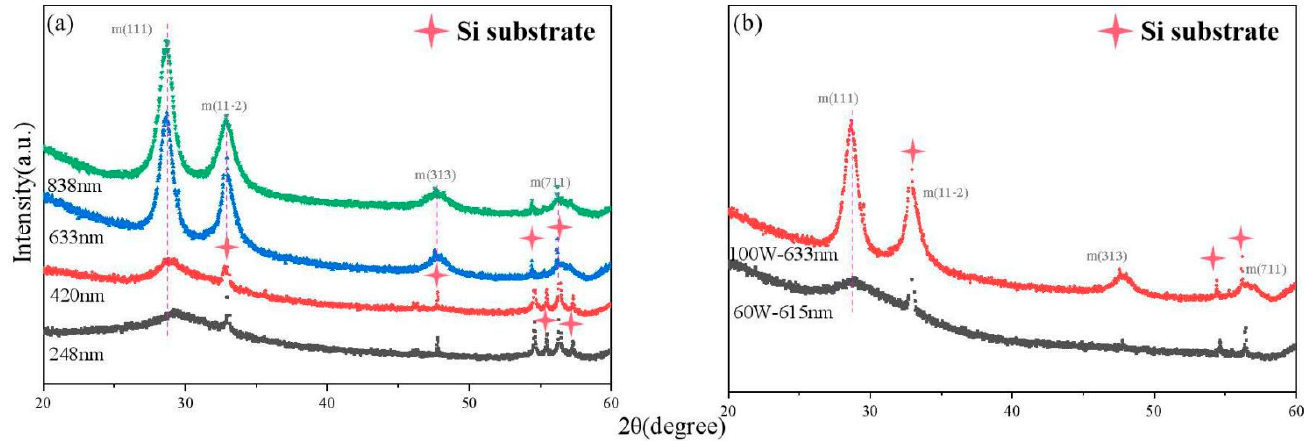
Figure 2. ( a ) The evolution of the as-deposited Y 2 O 3 films’ XRD patterns (samples 1-1 to 1-4); ( b ) comparison of the XRD patterns of samples 1-3 and 2-3.